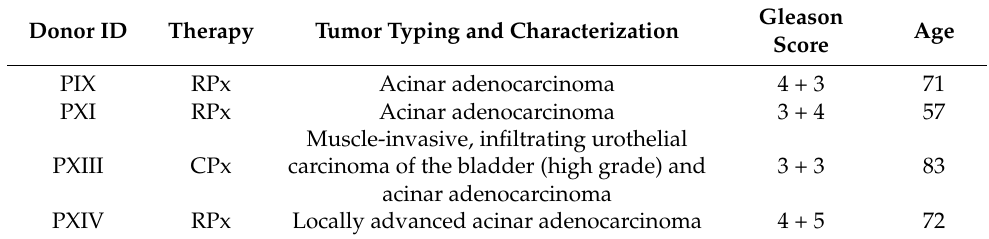
Table 1. Donor classification of prostate cancer